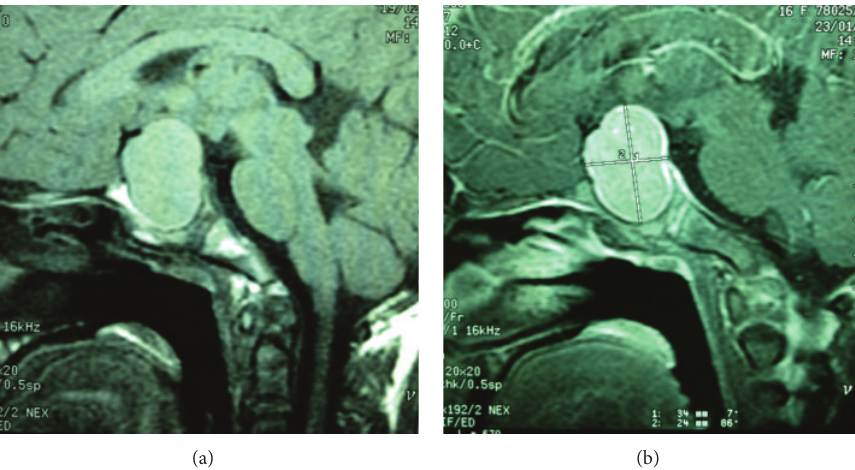
Figure 1: MRI demonstrates a lobulated contour of 3.2 × 4.3 × 3.4cm mass in sella turcica and suprasellar region (a). After intravenous Gd-DTPA, the mass shows intense enhancement with more intense enhancement in the periphery and central part (b).